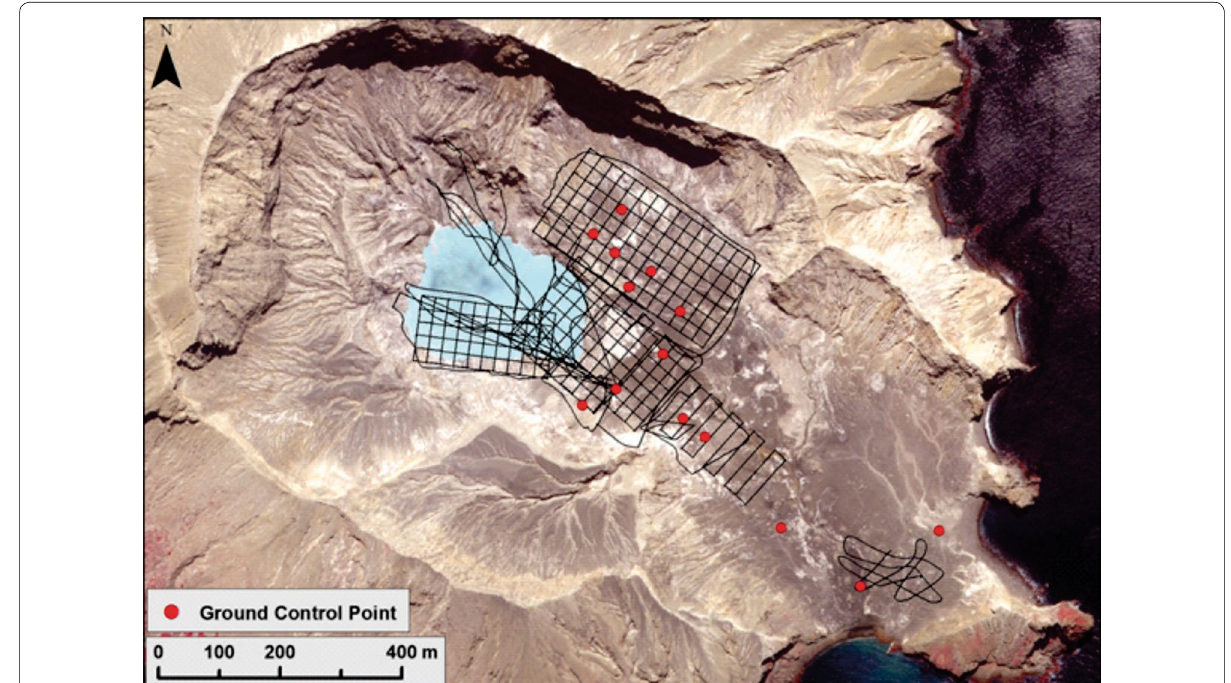
Fig. 5 Survey path of the drone-based digital elevation model of White Island from December 2016. We focussed most of the photogrammetry survey towards the western subcrater, which is periodically infilled by a warm, acidic lake. At the time, there was no lake present and this survey attempted to quantify the topography of the inner crater basin ~ 8 months after the eruption described here. We used 16 ground control points that were co-located with survey pegs—labelled in